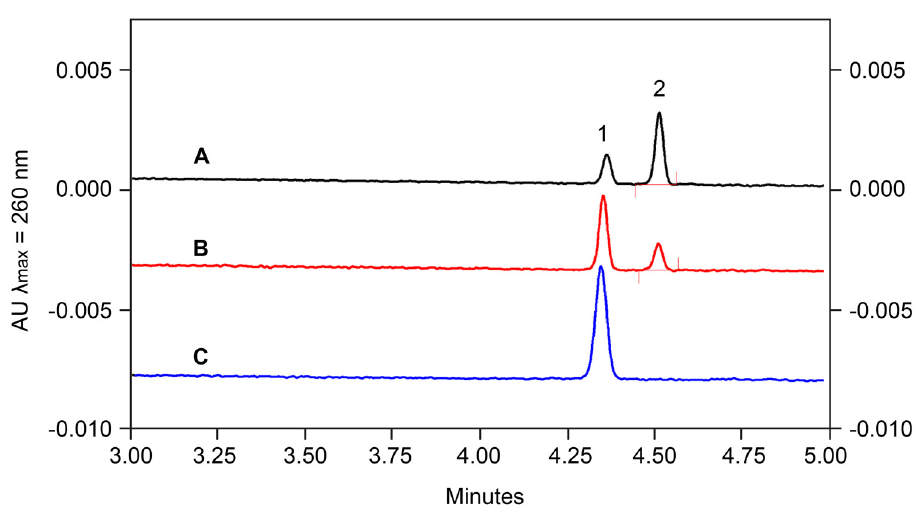
Fig 8. Tunicamycin inhibits MnaA in a concentration-dependent manner. Representative electropherograms of the MnaA-catalyzed conversion of UDP-ManNAc to UDP-GlcNAc in the absence of tunicamycin (A), in the presence of 100 μ M (B) and 200 μ M tunicamycin (C). Substrate concentration is 100 μ M. Peaks: 1 UDP-ManNAc; 2